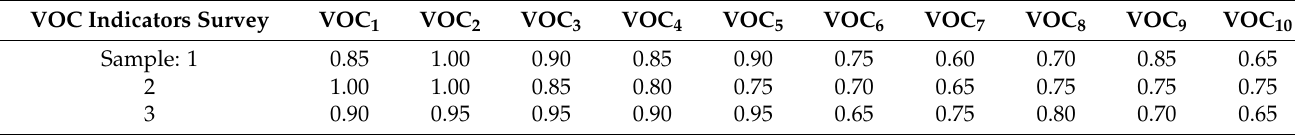
Table A3. Customer demand index survey